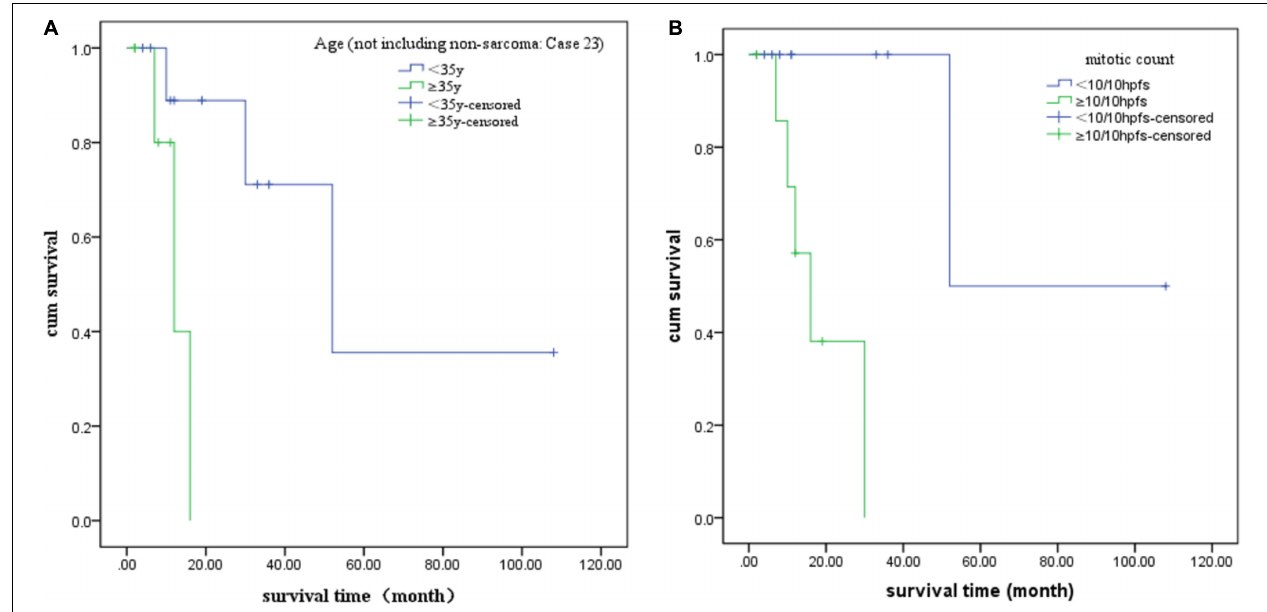
FIGURE 4 | Kaplan–Meier analysis curves of each statistically significant factor. (A) Age and (B) mitotic